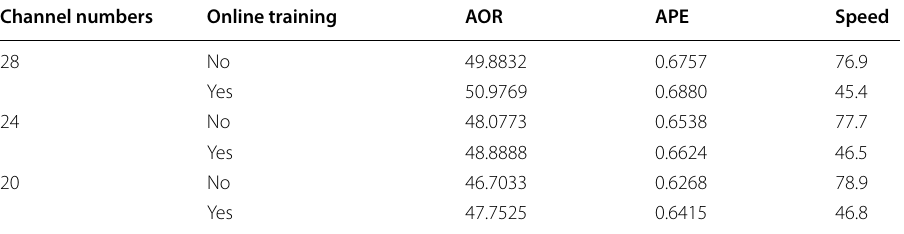
Table 3 Success and precision plots of different channels on OTB2013 datasets with online or non- online